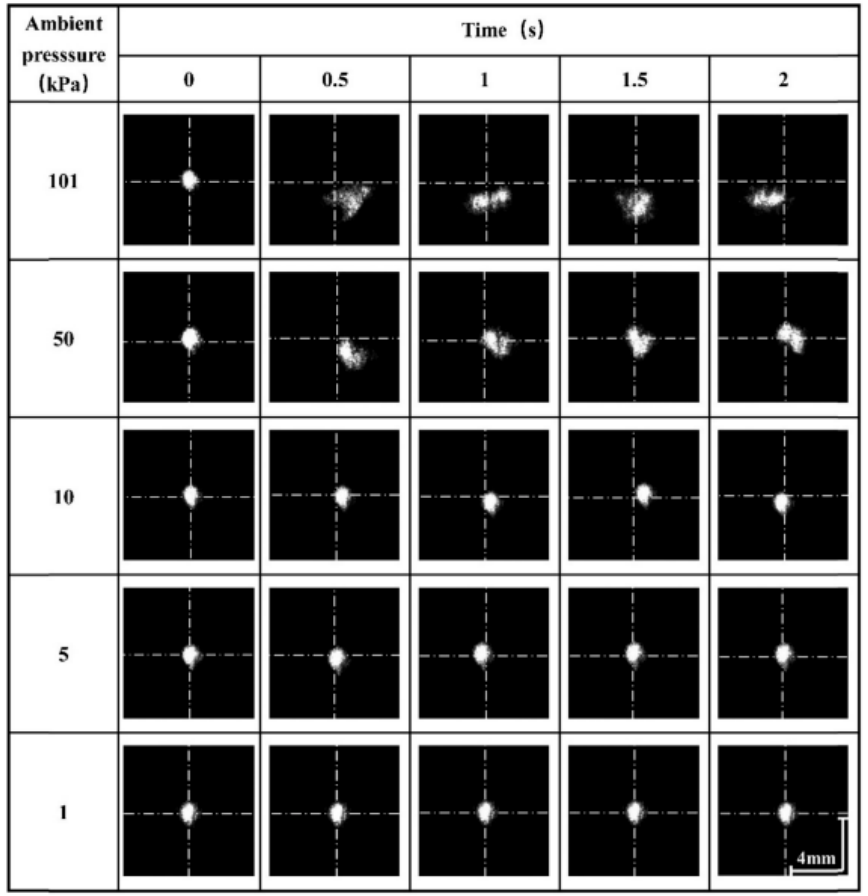
Figure 8. The spot behaviors of probe laser beam passing through the plasma plume under various ambient pressures (laser power is 5 kW, welding speed is 0.25 m/min, defocus distance is 0 mm). Reproduced with permission from [36], Elsevier, 2017.